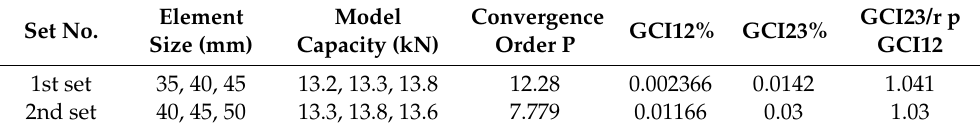
Table 2. Error estimation with GCI.